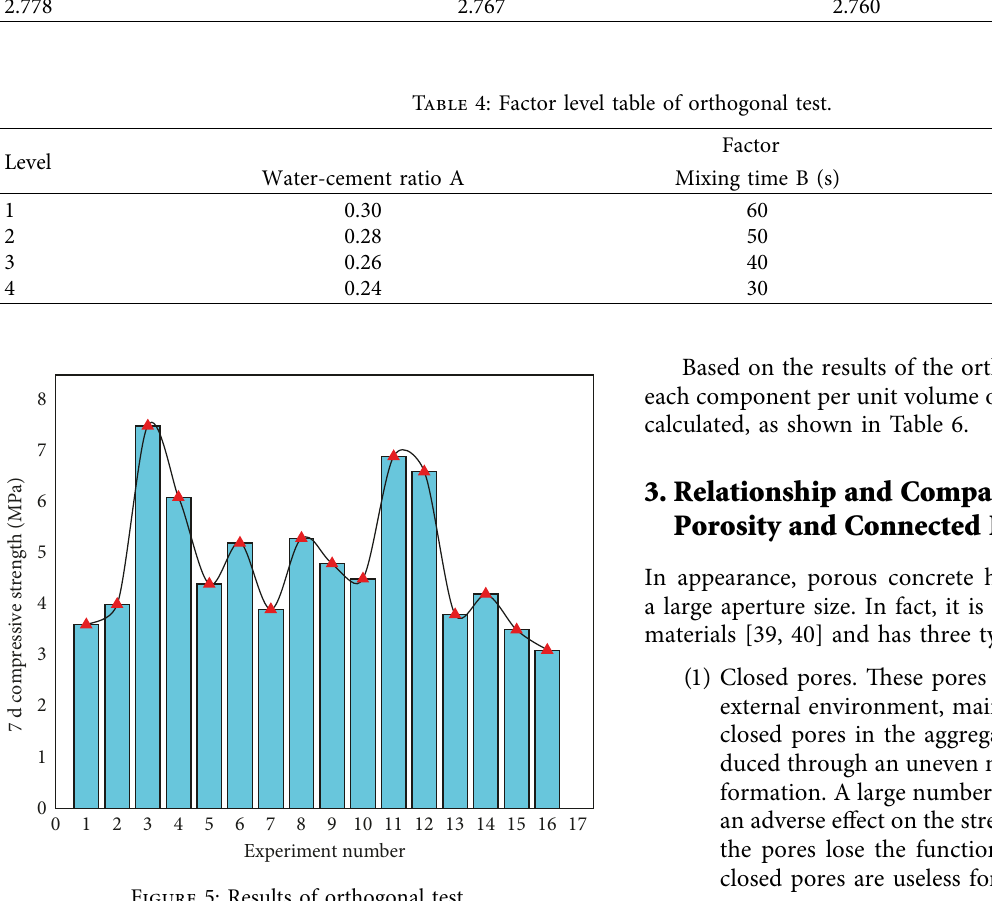
Figure 5: Results of orthogonal test.